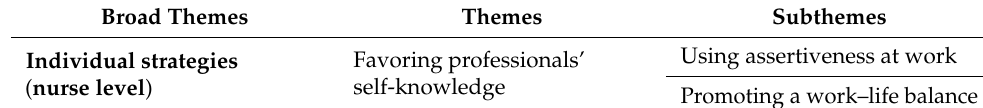
Table 3. Strategies to minimize presenteeism described by frontline nurses and nurse managers in both